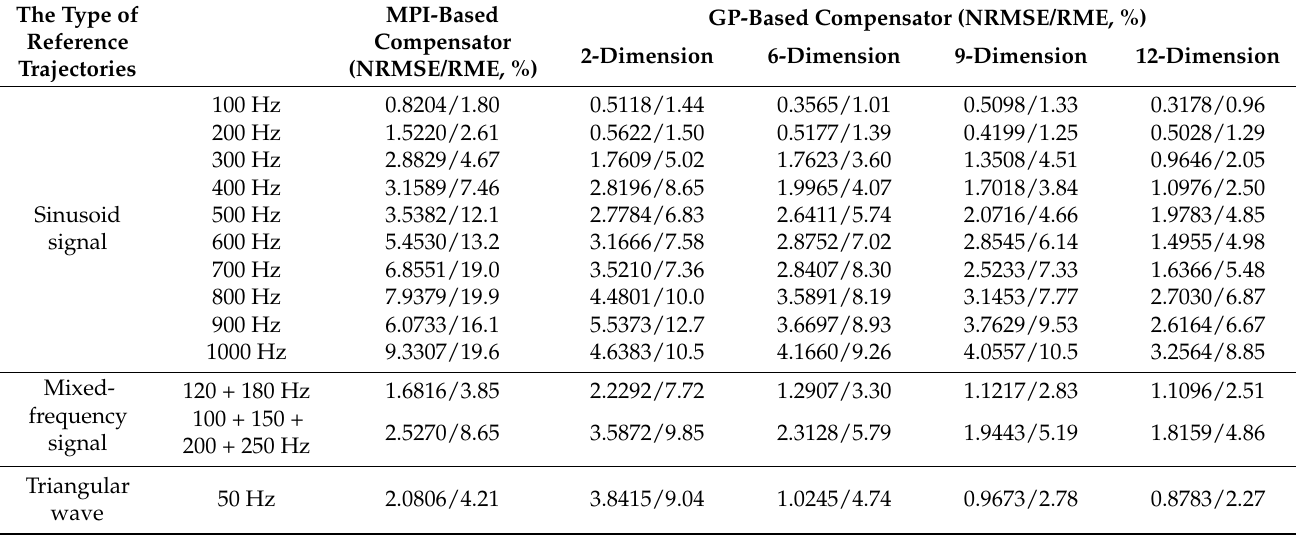
Table 2. Tracking results of the open-loop